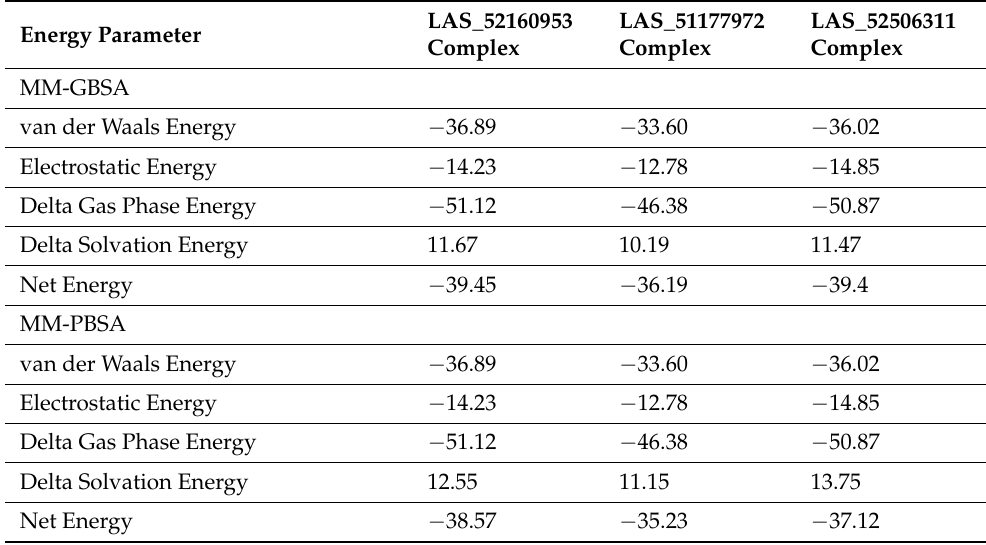
Table 2. MM-GBSA/MM-PBSA binding free energies of docked complexes, given in kcal/mol. Energy